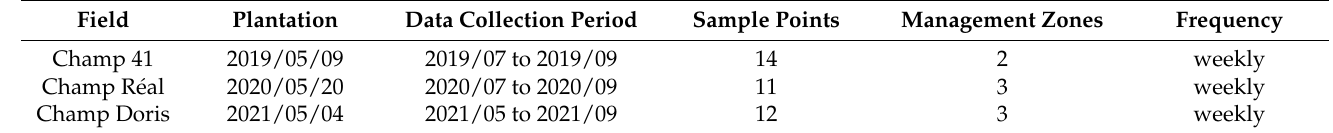
Figure 3. Average of root depth evolution (in cm) by MZ obtained in 2019 ( a ) and 2020 ( b ) growing seasons.